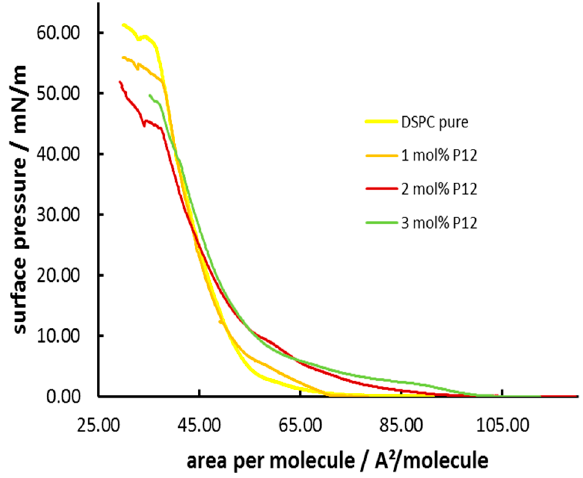
Figure 5. Isothermal surface pressure of a Langmuir-Blodgett monolayer at 25 °C with different amounts of lipopolypeptoids (pure DSPC, 1%, 2%, and 3% C 18 PSar 45 ).